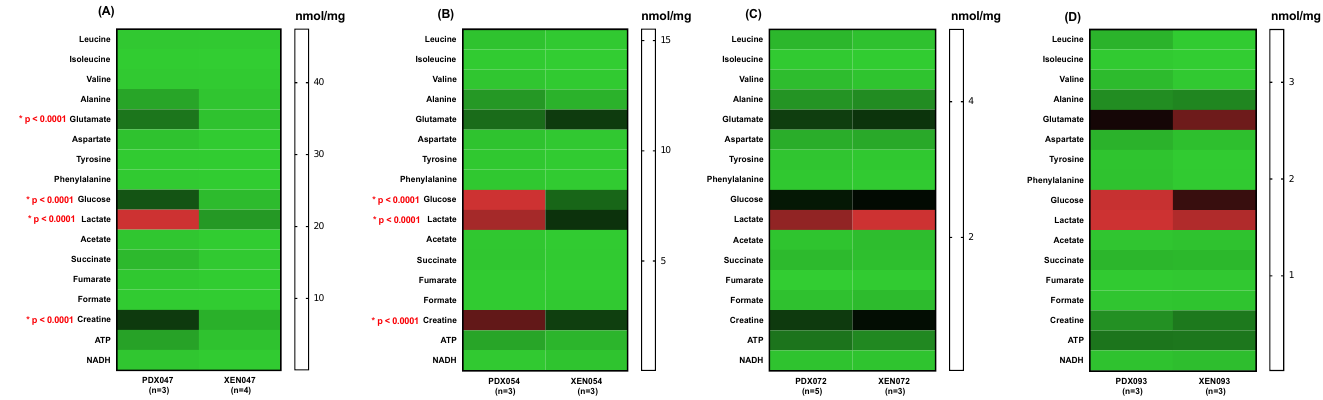
12 of 20 0.05, PDX047 and other PDX except PDX054, @: p < 0.05, PDX054 and other PDX except PDX047, $: p < 0.05, between PDX068 and PDX072, and PDX068 and PDX093, +: p < 0.05, between PDX072 and PDX093. Metabolite levels were relatively similar among the four XEN, although significantly different levels of glutamate, glucose, lactate, creatine, GPC, PE, GPE and taurine were noted between some of the XEN (Supplementary Figure S8A,B), with XEN047 and XEN054 having the highest levels (with the exception of XEN072 for GPC similar to that of PDX072). However, of note is that the trend of decreasing lactate levels observed when going from PDX047 to PDX093 is not recapitulated in XEN tumors. The lactate levels were